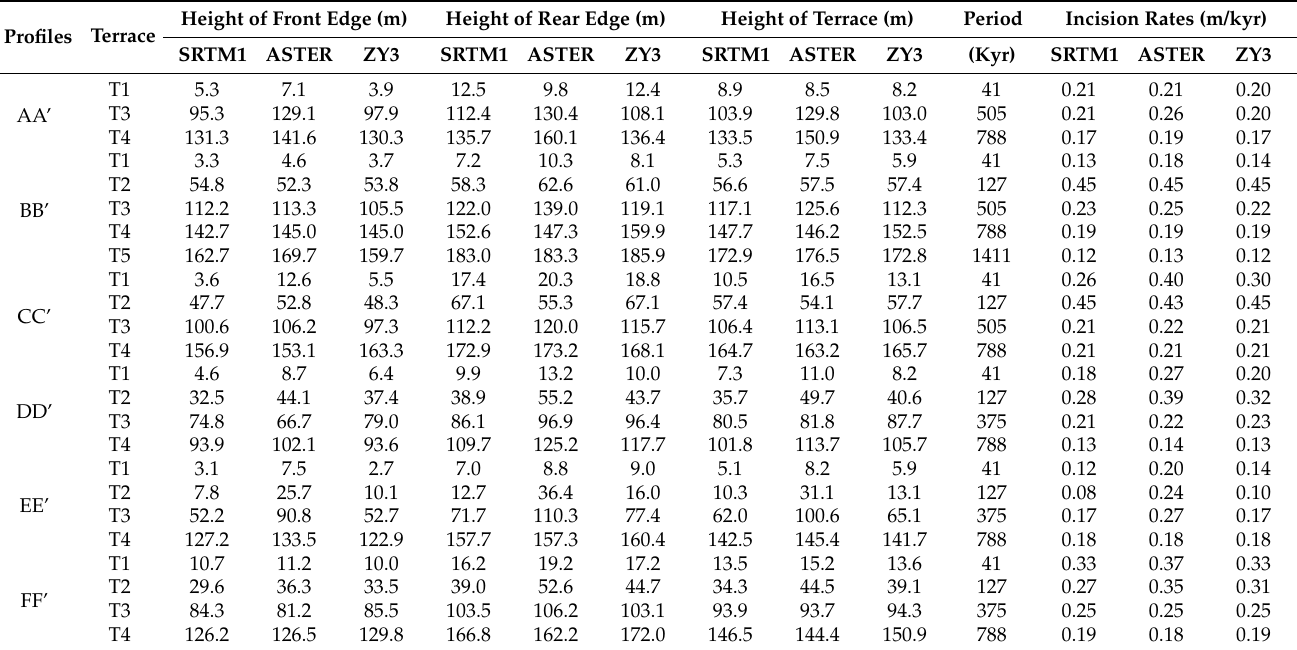
Table 6. The elevation of the terrace derived from SRTM1, ASTER GDEM, and ZY3 DEM. The periods of the terraces collected from